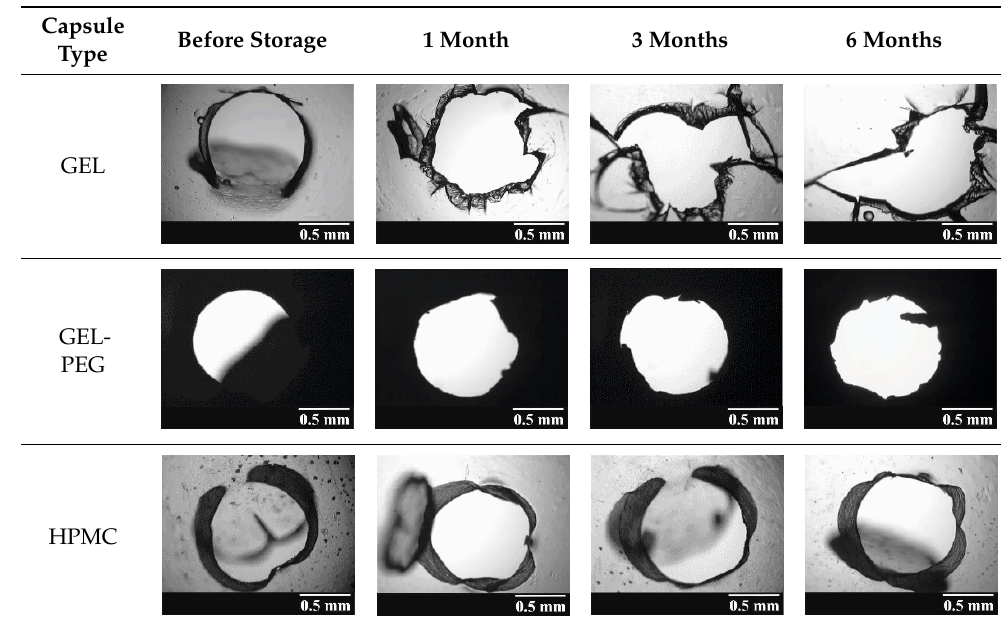
Table 2. Light microscopic images of the punctured ends of the applied DPI capsules.